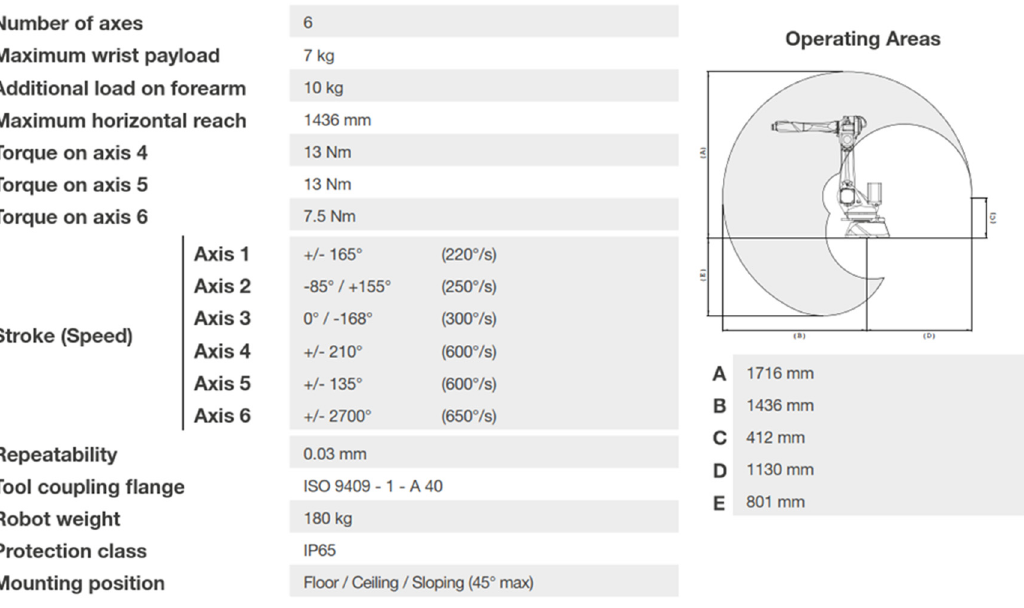
Figure 3. Technical features of Racer 7-1.4.